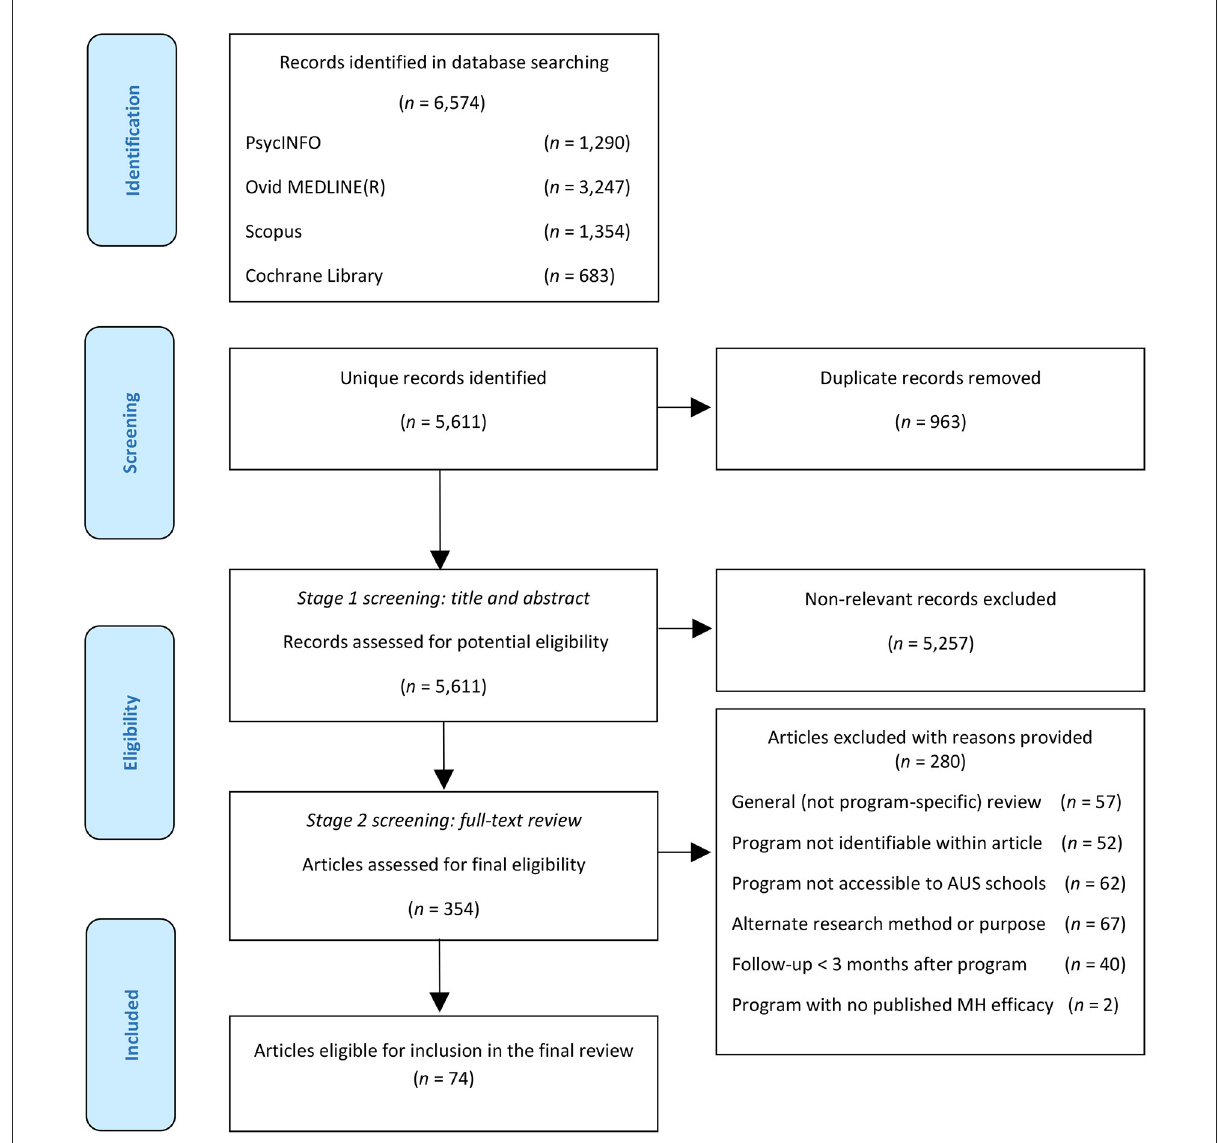
FIGURE1 Flowchart of the systematic literature review process and